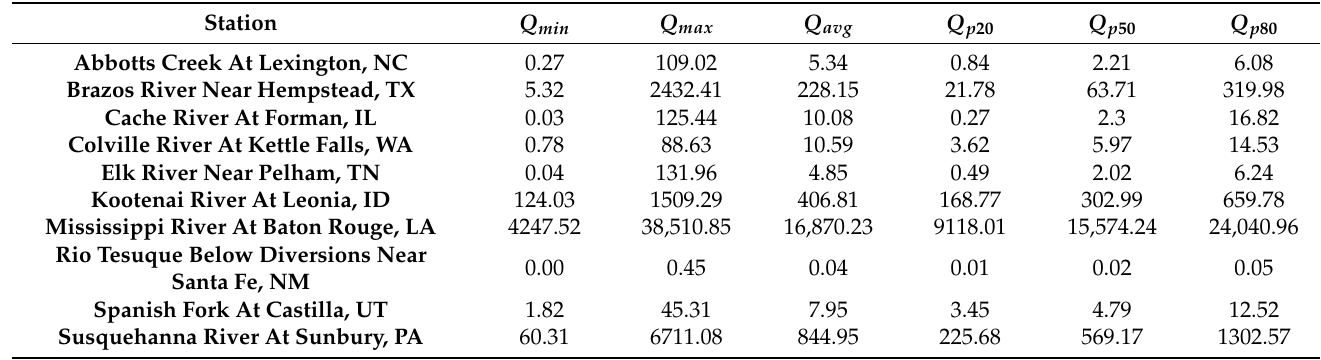
Table 4. The table lists the common discharge statistics for stations in the US. The Q min is the minimum flow, Q max is the maximum flow, Q avg is the average flow, Q pn represents the n th percentile flow for the station across the timeseries. The unit of Q is m 3